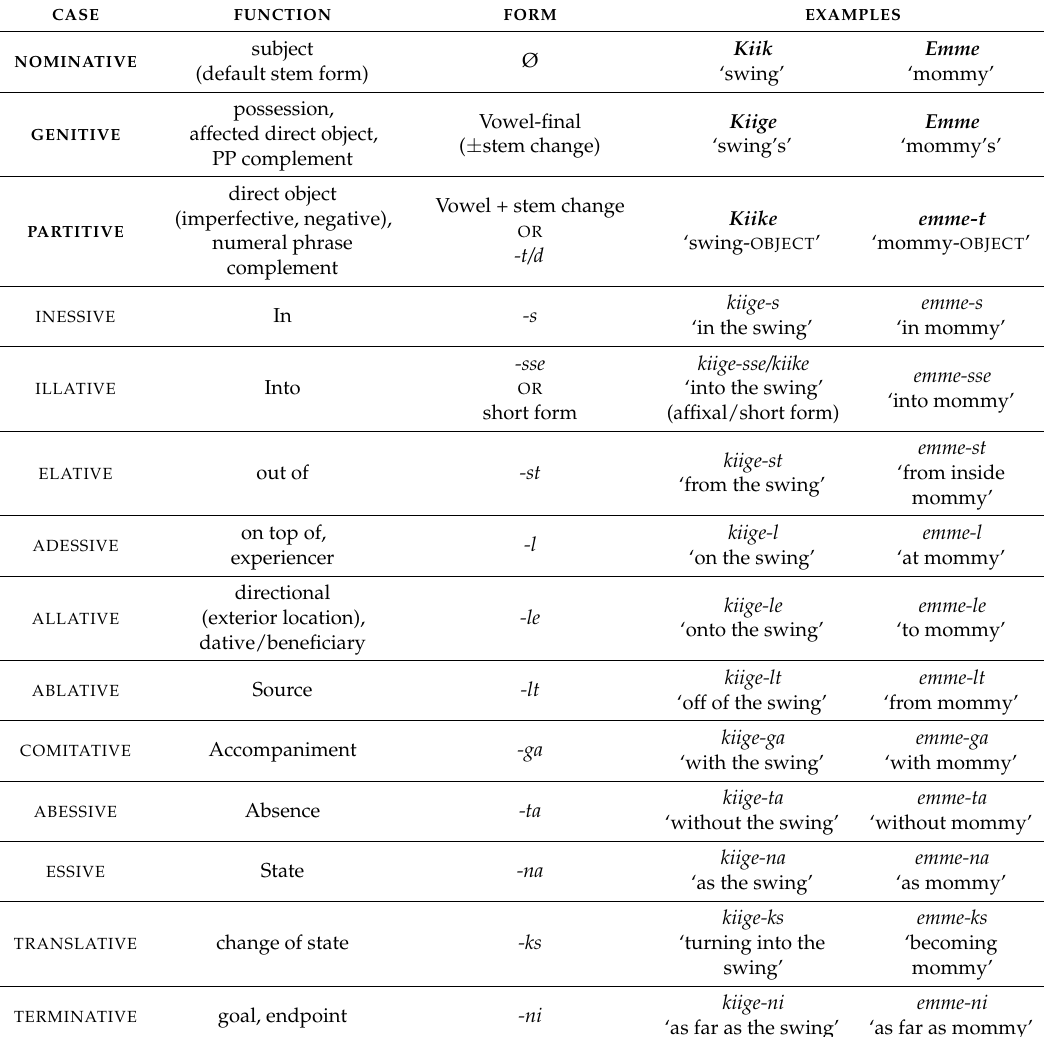
Table 1. Noun case system in Estonian: overview of functions and